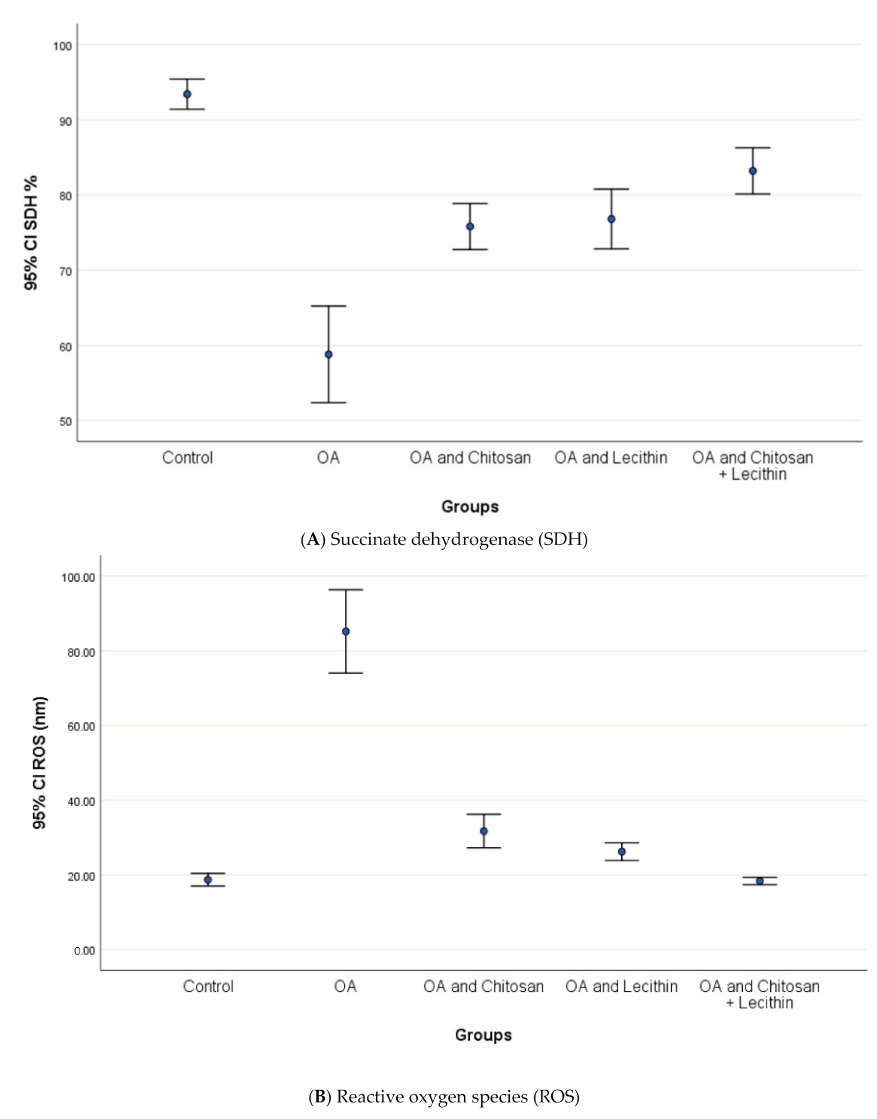
Figure 5. The e ffi cacy of chitosan and lecithin against: ( A ) succinate dehydrogenase (SDH) and ( B ) reactive oxygen species (ROS) in (OA) model induced by monoiodoacetate (MIA) in male rats. Where Fluorescence intensity (Relative wave length and content for DCF) (Indication for ROS content). The data presented as mean ± S.